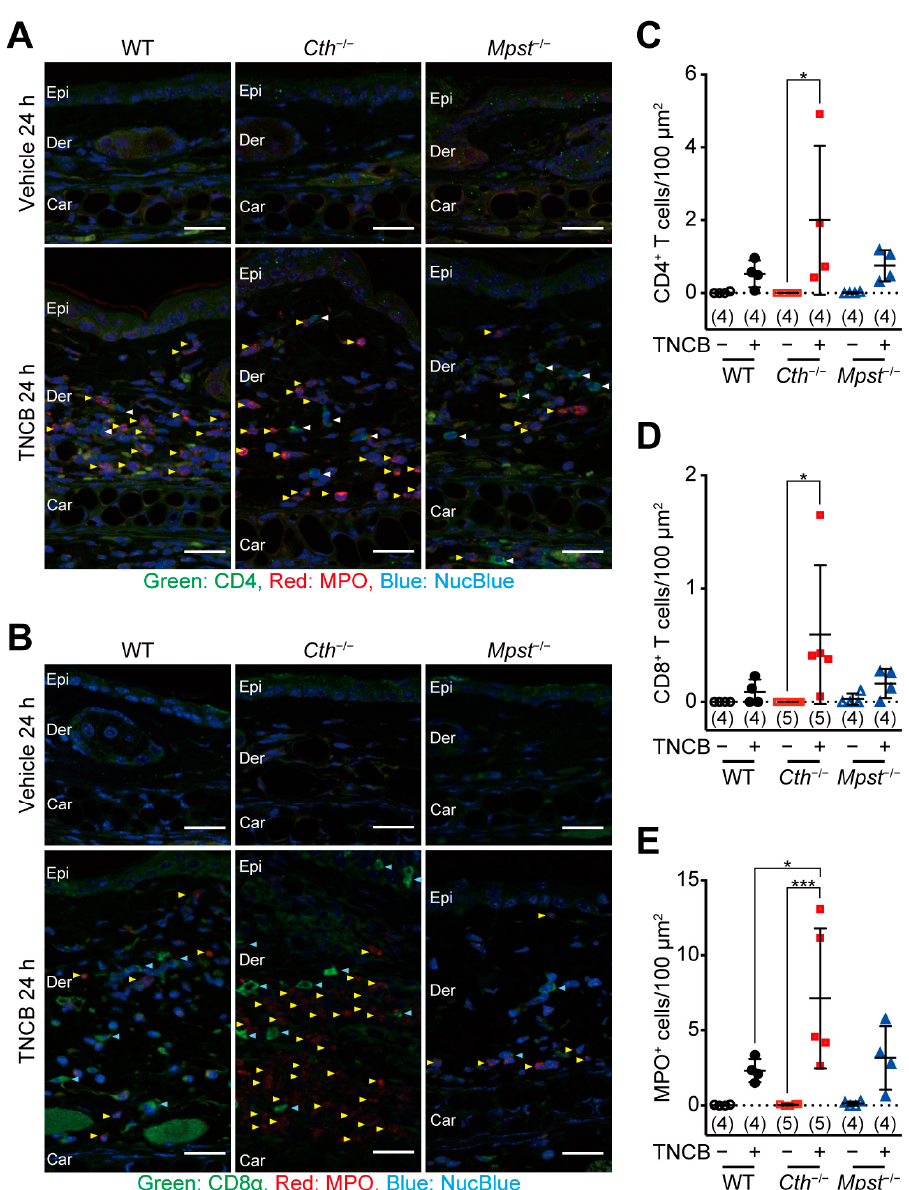
Figure 3. Immunohistochemical analysis of ear sagittal sections at 24 h after the trinitrochlorobenzene (TNCB) challenge. ( A ) Coimmunostaining with anti-CD4 antibody (green), anti-myeloperoxidase (MPO) antibody (red), and NucBlue (to stain nuclei, blue). White and yellow arrowheads indicate CD4 + cells and MPO + cells, respectively. ( B ) Coimmunostaining with anti-CD8 α antibody (green), anti-MPO antibody (red), and NucBlue (blue). Light blue and yellow arrowheads represent CD8 + and MPO + cells, respectively. SC, stratum corneum; Epi, epidermis; Der, dermis; and Car, cartilage in ( A , B ). ( C – E ) Distribution density of CD4 + ( C ), CD8 + ( D ), and MPO + ( D ) cells per 100 µ m 2 . Data are the mean ± SD (sample numbers). Differences between groups in each time point are significant by a one-way ANOVA with Tukey’s multiple comparison test at * p < 0.05 and *** p < 0.001 ( C – E ). White bars indicate 25 µ m ( A , B ).